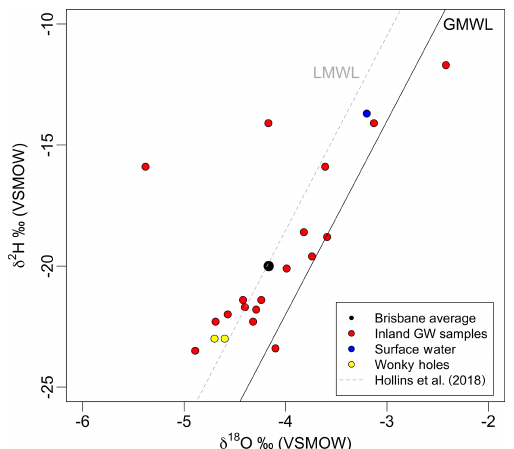
Figure 4. δ 18 O and δ 2 H values of groundwater, surface water and water from the wonky holes on North Stradbroke Island. The black point represents the rainfall-weighted average composition of δ 18 O and δ 2 H for rainfall from the Global Network of Isotopes in Precipi- tation for Brisbane from 1962 to 2014 (Hollins et al., 2018). LMWL denotes the local meteoric water line for Brisbane, and GMWL refers to the global meteoric water